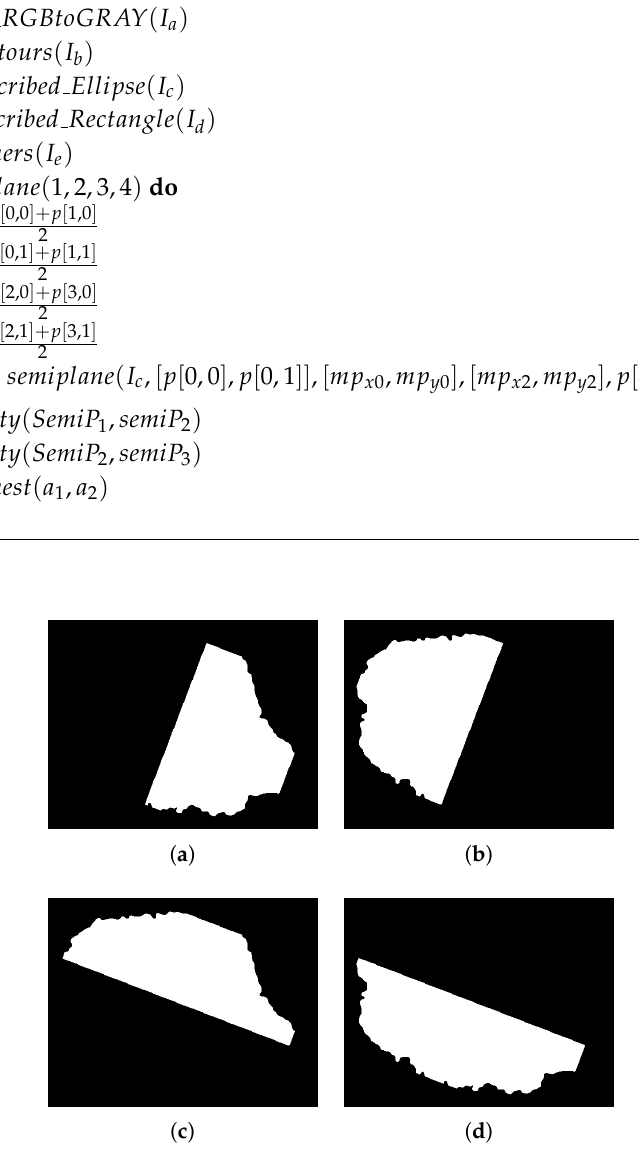
Figure 5. Symmetry and shape identification test. ( c , d ) comparison using the largest axis, ( a , b ) comparison using the smallest axis.